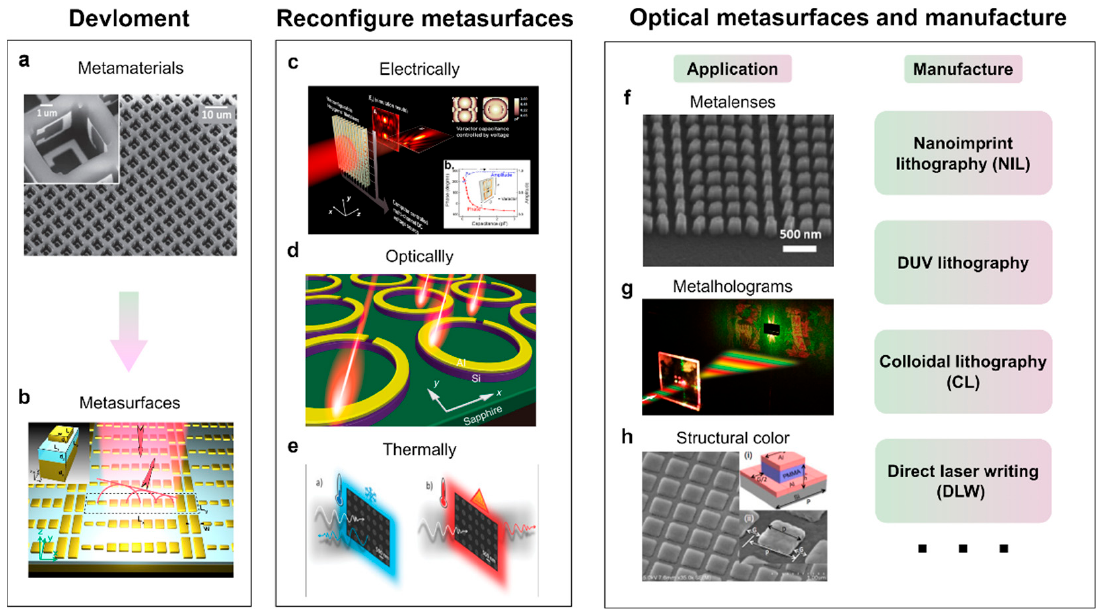
Figure 8. Basic science of metasurfaces. ( a ) Reprinted with permission from Ref [69]. Copyright ©